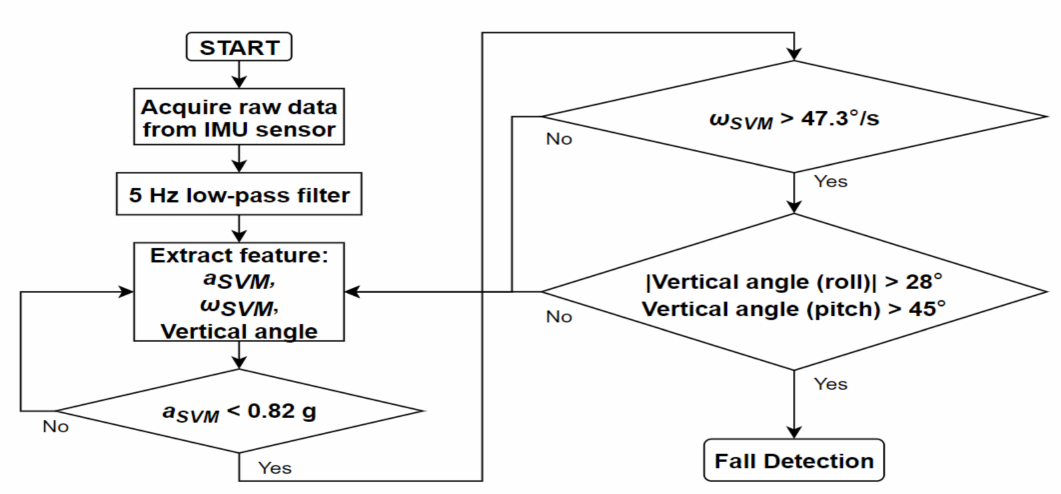
Figure 10. Flow chart of the proposed